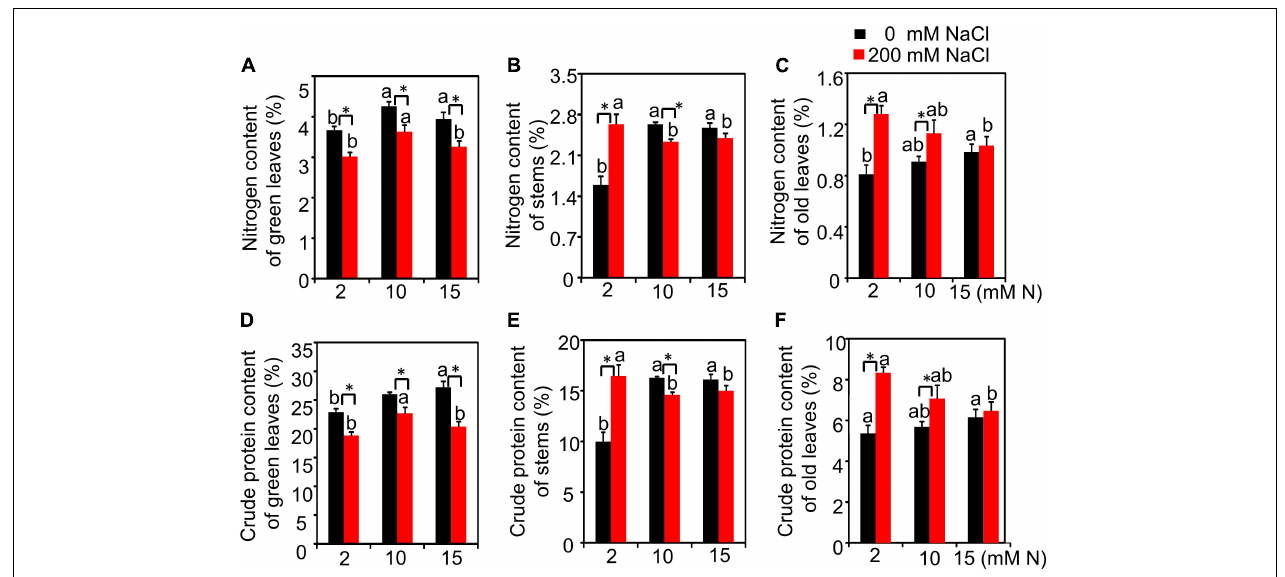
FIGURE 4 | The nitrogen content and crude protein content of bermudagrass under different treatments. Nitrogen content of green leaves (A) , stems (B) , and old leaves (C) . Crude protein of green leaves (D) , stems (E) , and old leaves (F) . Different letters above the columns indicate statistically significant differences at P < 0.05 under different N levels with the same NaCl level by Tukey’s test. ∗ Shows significant differences ( P < 0.05) under 200 mM NaCl treatment and 0 mM NaCl condition with the same N level by Tukey’s test.